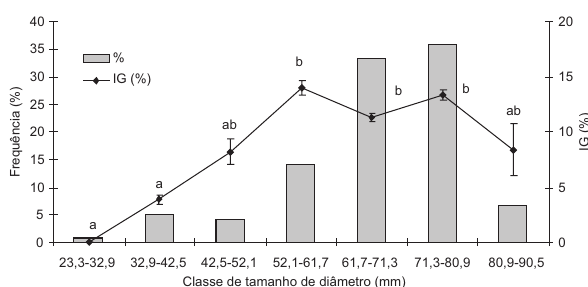
Figura 4. Distribuição do IG (%) (média ± erro padrão) e frequência relativa nas diversas classes de diâmetro corpóreo para a população ficativas para o IG pelo teste de Kruskal Wallis e teste Tukey não paramétrico (p <